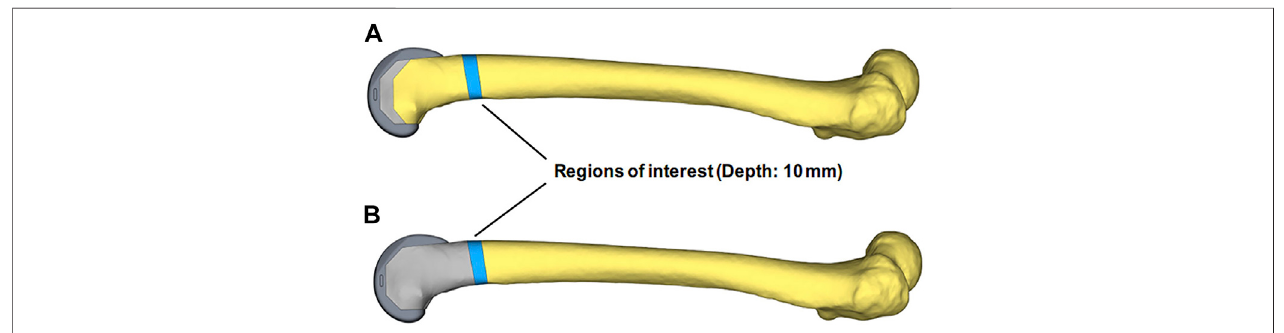
FIGURE 4 | The regions of interest (ROI) de fi nition of the two groups ’ models. The blue areas of (A, B) were the selected regions of interest, located in the same 10 mm femoral scale above the UHMWPE block.